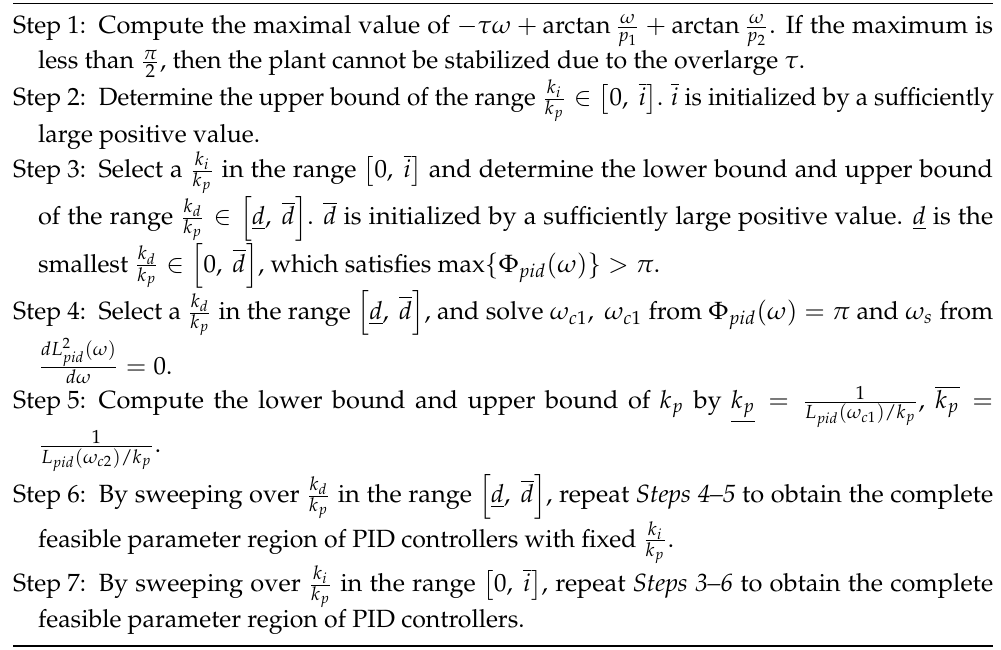
Algorithm 2 The algorithm for the feasible PID parameter region of the plant